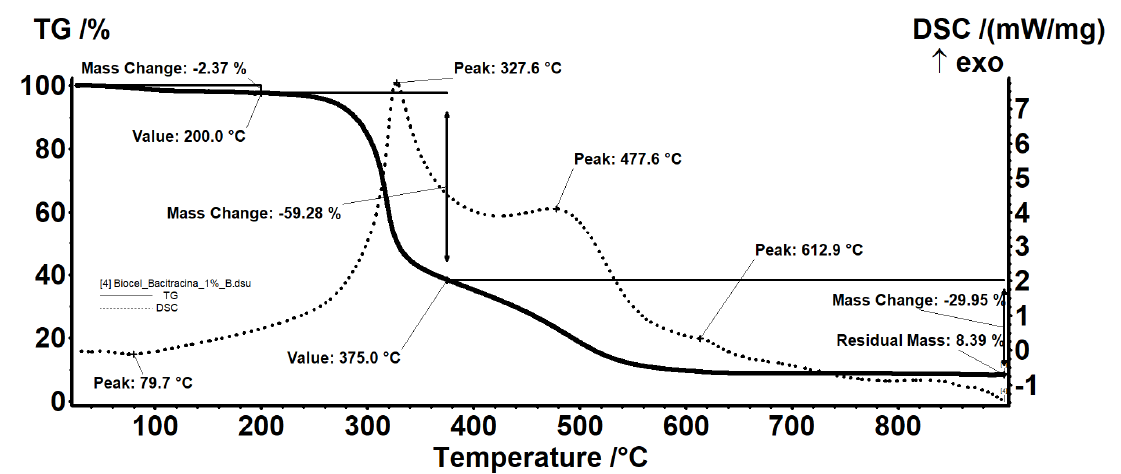
Figure 4. Thermal analysis of BC-bacitracin 1%.